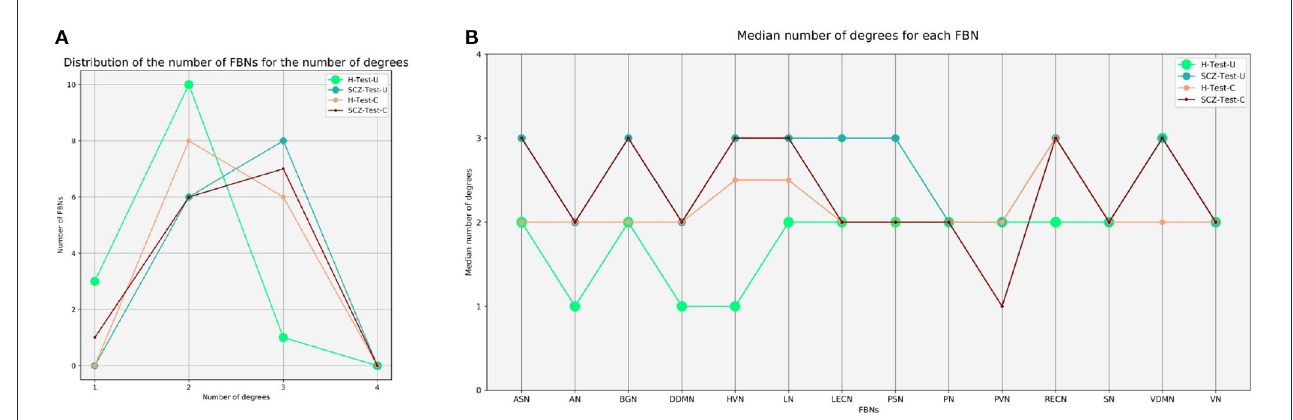
FIGURE8 Graph theory analysis for the COBRE dataset. (A) Distribution of the number of FBNs for the number of degrees, for the H-Test-U, SCZ-Test-U, H-Test-C, and SCZ-Test-C groups. (B) Representation of the median number of degrees for each FBN, for the H-Test-U, SCZ-Test-U, H-Test-C, SCZ-Test-C groups.